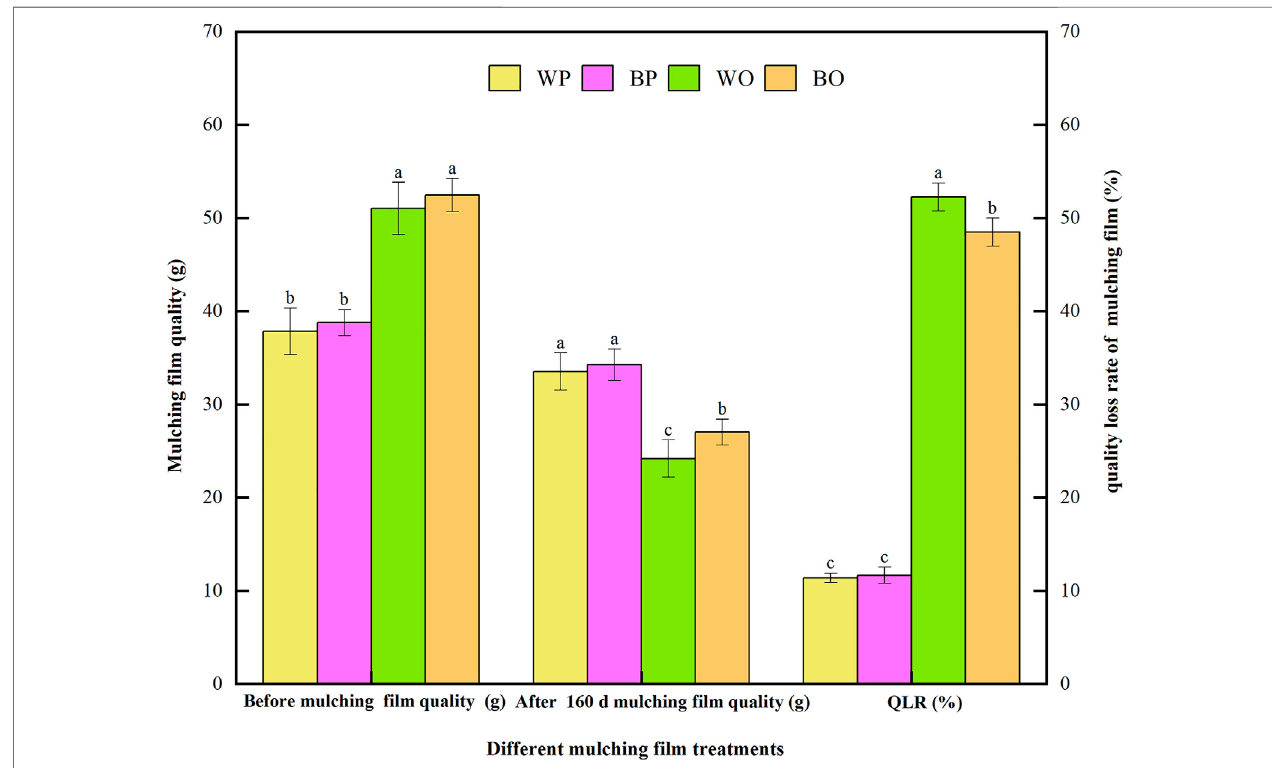
FIGURE 1 | Degradable degrees of different mulching fi